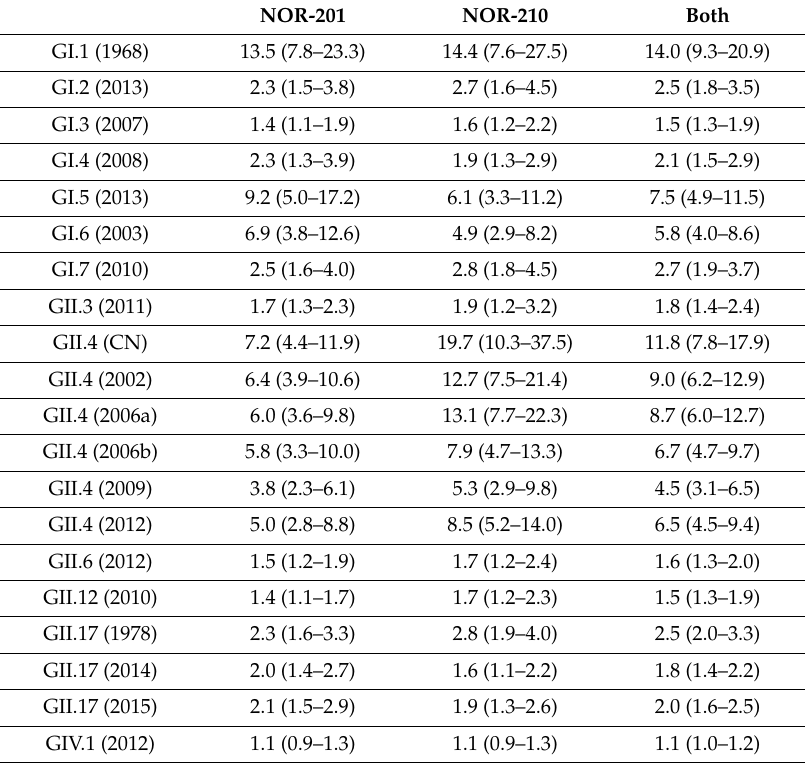
Table 5. Geometric mean fold-rise of titers after